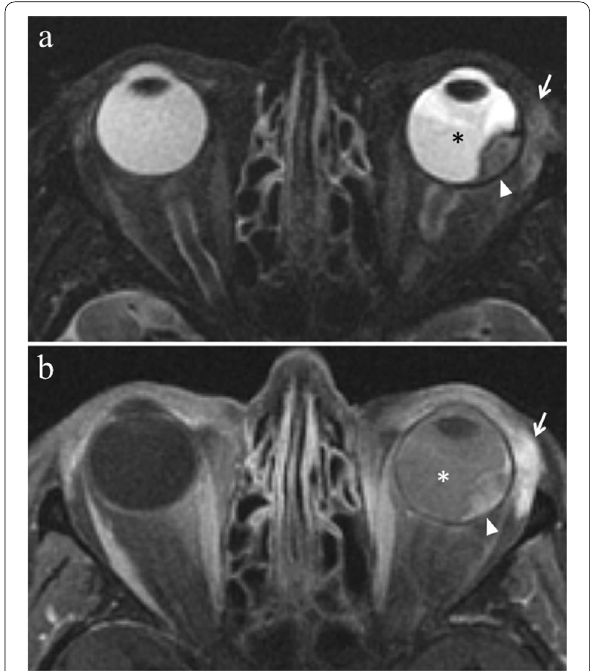
Fig. 15 A 75-year-old woman with inflammatory swelling of the lacrimal gland after proton-beam radiotherapy for choroidal melanoma of the left eye. The same patient as in Fig. 12. Axial a T2-weighted turbo spin-echo STIR and b contrast-enhanced fat-suppressed T1-weighted images demonstrate an enlarged left lacrimal gland with marked enhancement (white arrows). A dome-shaped intraocular lesion (white arrowheads) is recognizable along the lateral aspect (temporal area) of left globe, adjacent to the lacrimal gland. Note the inhomogeneous signal intensity of the left vitreous body on T2- and T1-weighted sequences (asterisks), a finding consistent with vitreous hemorrhage